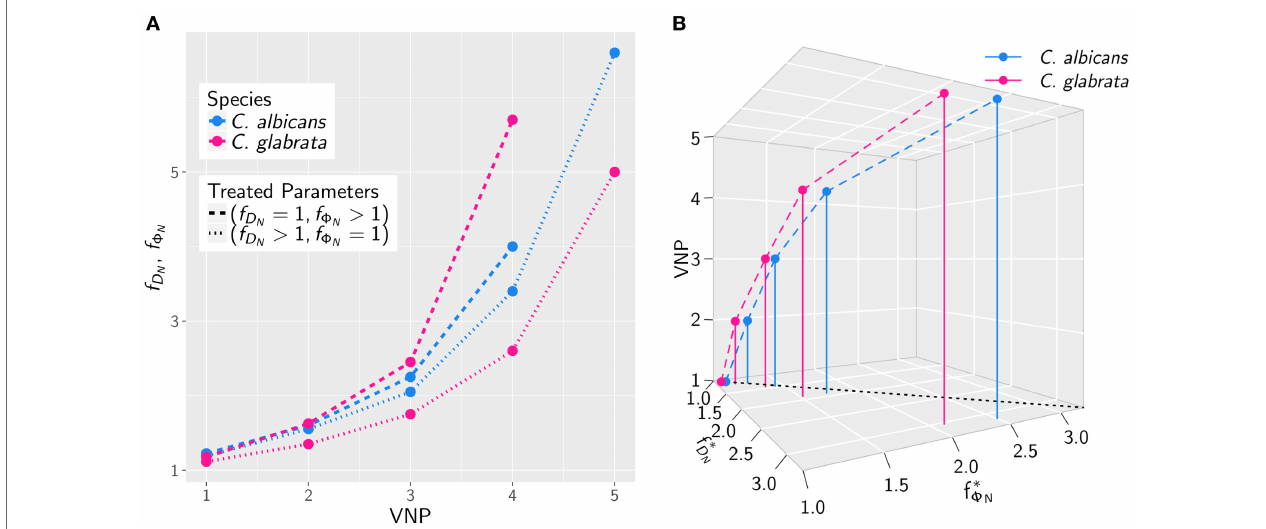
FIGURE 8 | The increase in neutrophil activation required to reach the infection outcome of non-neutropenic patients depends on the severity degree of neutropenia in VNP. (A) Comparison of Candida albicans (blue) and Candida glabrata (pink) infection for various VNP in terms of the factors f D = 1 fixed. (B) The same as in panel (A) allowing both factors to vary to attain the optimal values ( f (cid:3) φ f D N which the infection outcome of non-neutropenic patients is